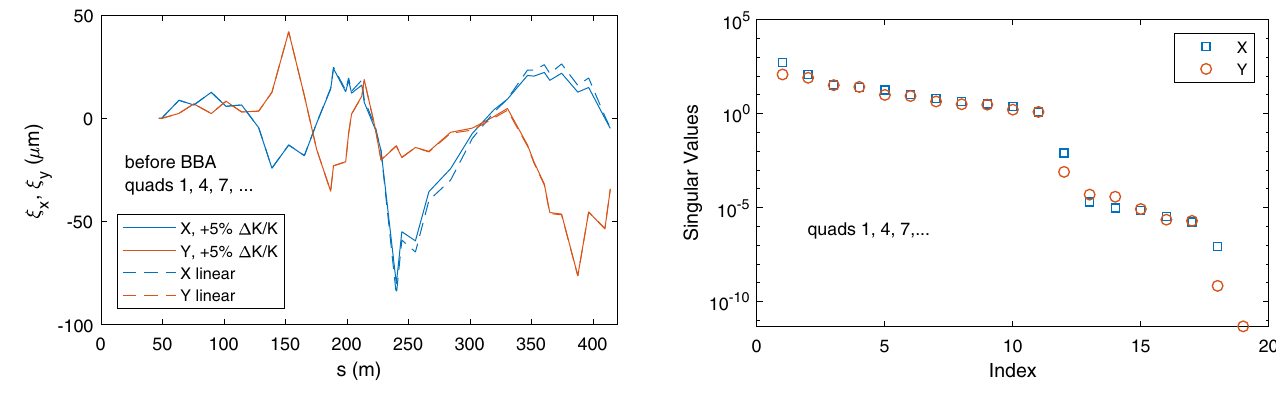
FIG. 2. The induced trajectory shift by a 5% increase of the strengths of group 1 quadrupoles. Solid lines show actual values obtained by tracking. The dashed lines ( “ linear ” ) show the values scaled up from a 0.1% gradient change by a factor of 50.